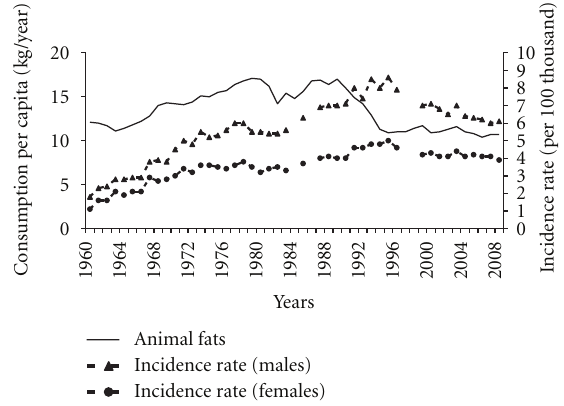
Figure 3: Animal fats consumption and pancreatic cancer morbid- ity